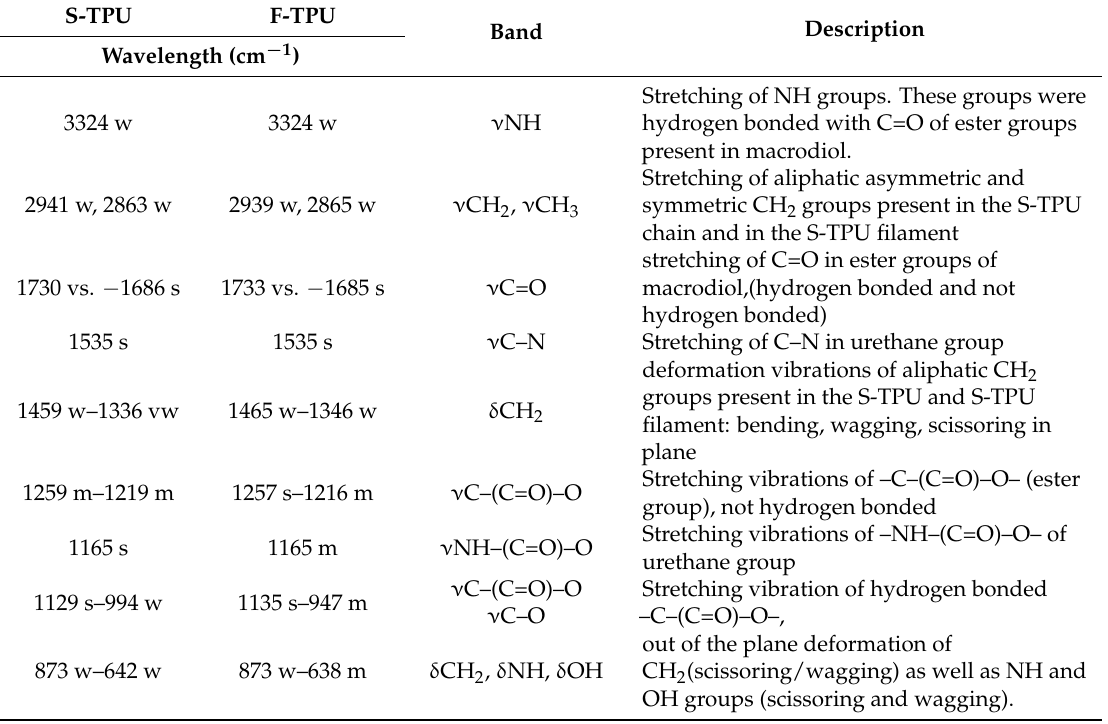
Table 3 Band assignments noted at the FTIR spectra of S-TPU and F-TPU filament.